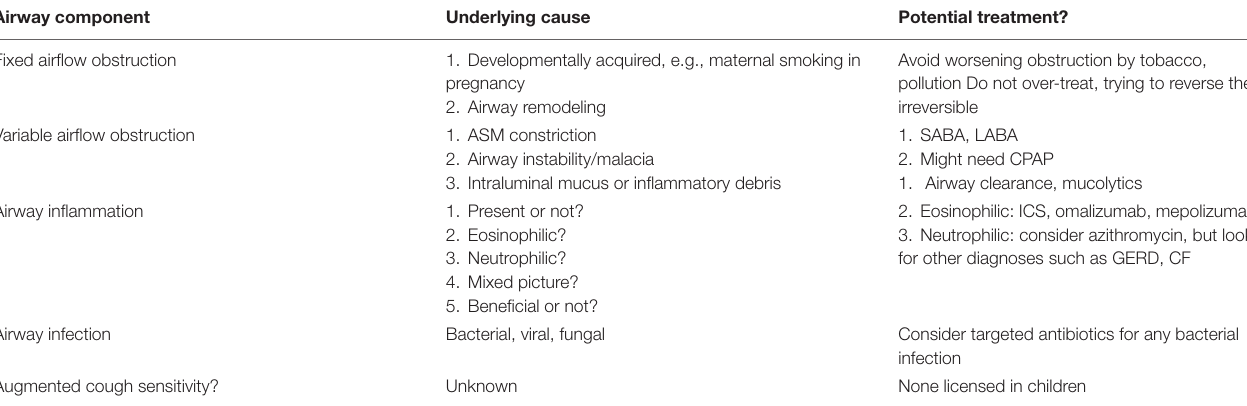
TABLE 2 | Deconstructing the airway to plan treatment. Underlying cause Potential